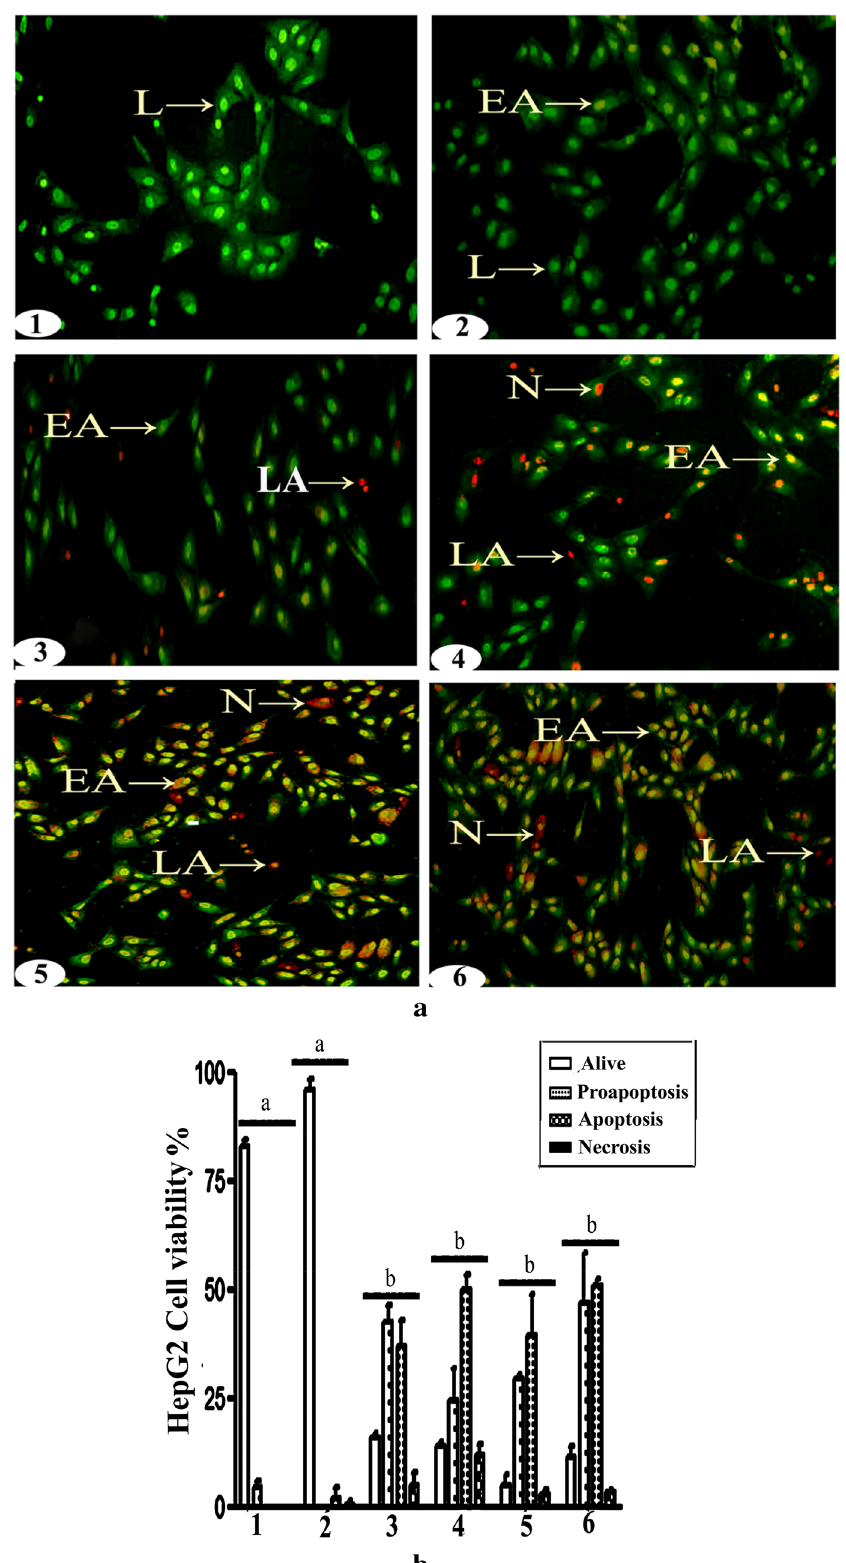
Figure 3. Curcumin and nanocurcumin induced apoptosis of HepG2 hepatic cancer cells. ( a ) EB/AO staining of HepG2 cells ( 1 = control, 2 = AC, 3 = AC + Cur, 4 = AC + NCur, 5 = Cur, 6 = NCur) (X = 200). (b) Results expressed as mean ± SEM. In the following figures, L = live cells, EA = early apoptotic cells, LA = late apoptotic cells, and N = necrotic cells. Values in the same column with unlike superscript letters are significantly different at p <